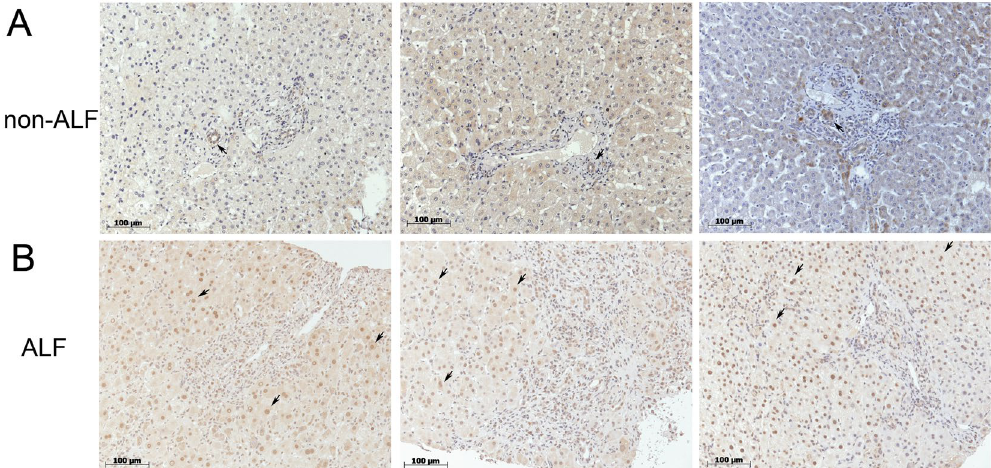
Figure 1. In acute liver failure (ALF) KLF6 expression is induced in hepatocytes. KLF6 protein was visualized in liver tissue of ALF patients by immunohistochemistry. Representative tissue sections of patients with drug- induced ALF ( B ) or non-acute liver injury patients ( A ) stained with KLF6 by immunohistochemistry are shown (20-fold